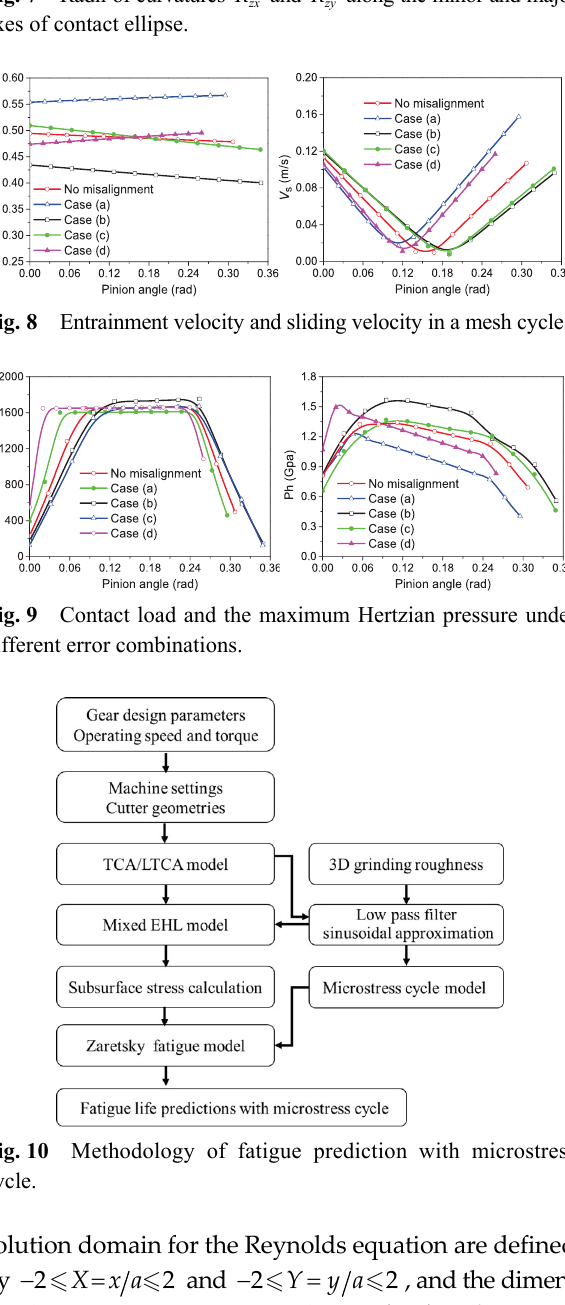
R along the minor and major R and zx zy